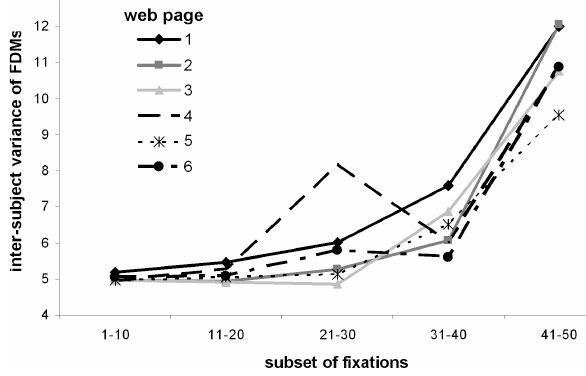
Figure 7. Mean inter-subject variance of fixation density maps (FDMs) with respect to subsets of fixation and separated for the web pages. Each subset includes ten fixations regarding their temporal occurrence after web page onset. Values on the ordinate were scaled up by multiplying with 10 11 , but absolute values are negligible in general.